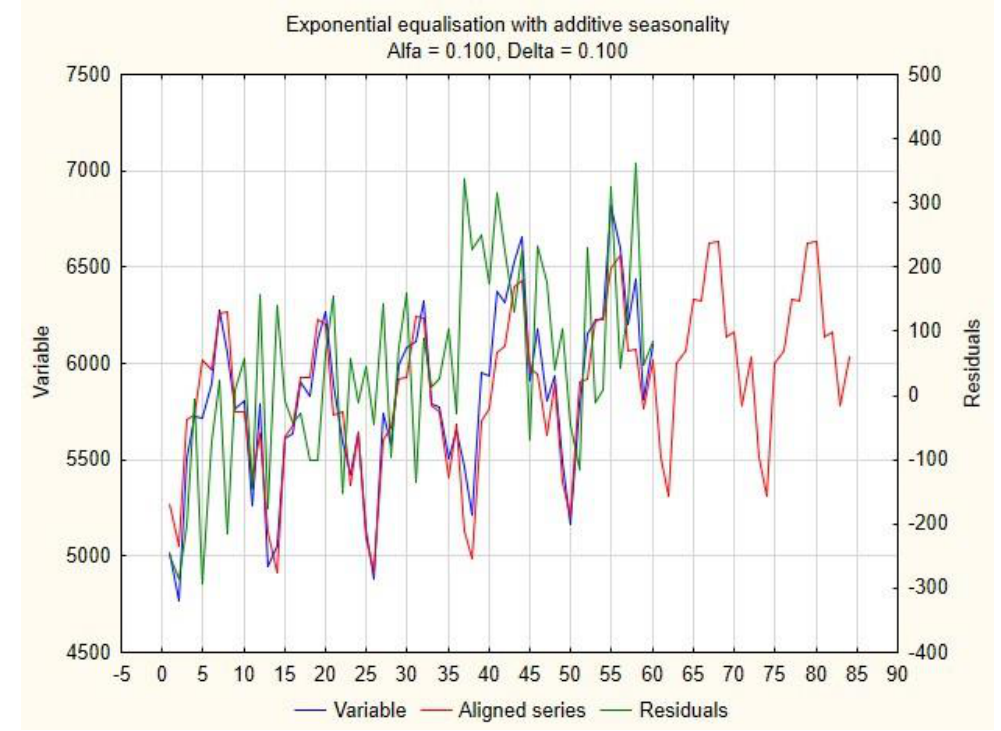
Figure 9. Exponential smoothing of motor gasoline supplies. Source: own elaboration. The values of the forecasts obtained on the basis of this are presented in Table 5, and the forecast errors are in Table 6. Table 5. Motor gasoline supply forecasts on a monthly basis for 2020 – 2021 (in thousand tonnes). Source: own elaboration.